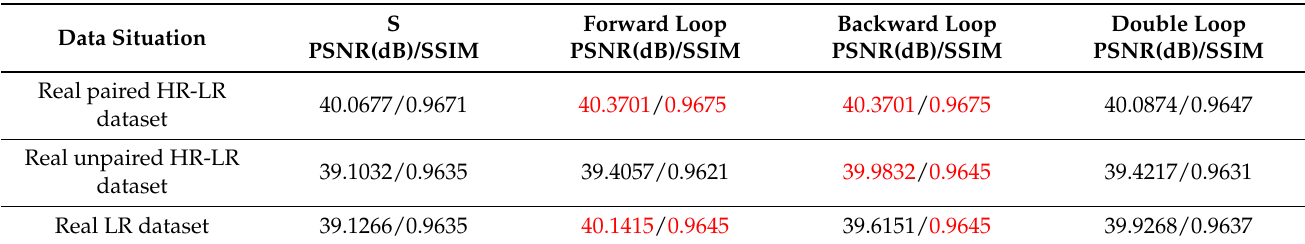
Table 5. Results of different training modes under different data situations on the PROBA-V dataset. The best results are marked in